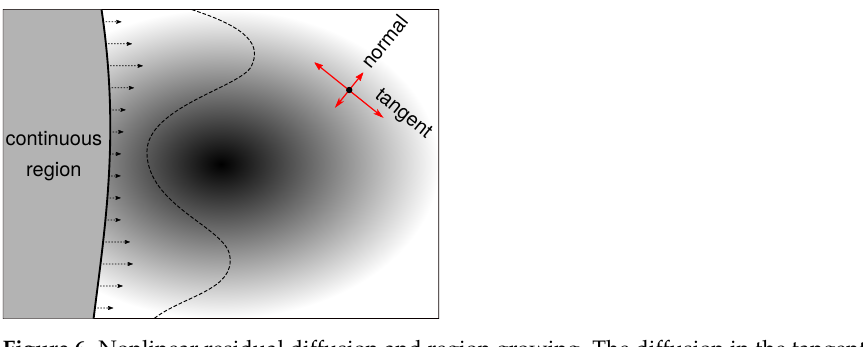
Figure 6. Nonlinear residual diffusion and region growing. The diffusion in the tangent direction of the contour is designed to be stronger than that in the normal direction, which drives regions to grow faster in flatter